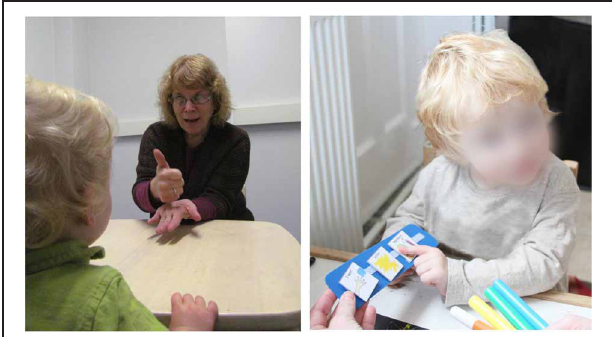
FIGURE 2 | Augmentative and Alternative Communication (AAC) interventions. Child and therapist engaged in Sign Language Training (left) vs. Picture Exchange Communication System (PECS) training (right). Sign Language Training (SLT) uses behaviorist imitation and prompting methods to teach children to use hand, arm, facial, and other body actions to produce symbolic communications. The Picture Exchange Communication System (PECS) uses behaviorist methods to teach children to hand one or more pictures to a variety of communicative partners, in order to request items/activities, respond to simple questions, and